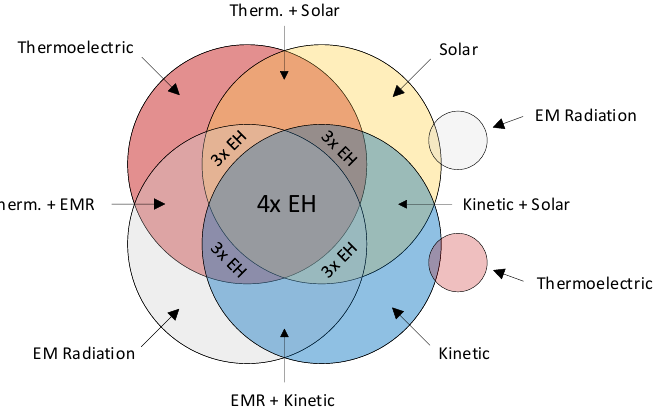
Figure 1. Energy sources and